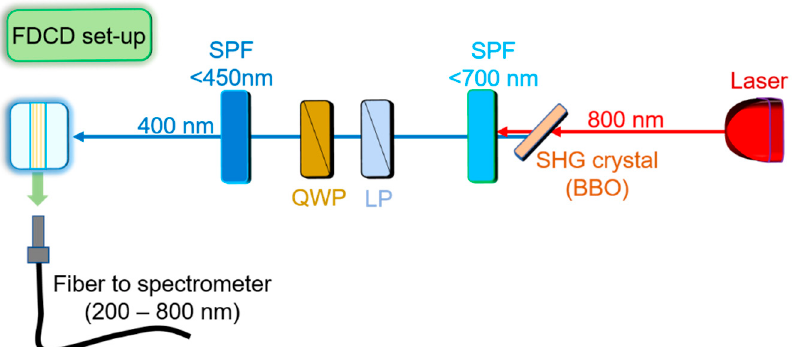
Figure 3. Experimental FDCD setup. Laser light at 800 nm impinges on the BBO crystal, which generates the second harmonic. The high-intensity fundamental beam is filtered by two short-pass filters, while the second harmonic is polarized by a linear polarizer and quarter waveplate. This beam excites the cuvette with molecules. Fluorescence is laterally caught by a fiber and sent to the spectrometer.